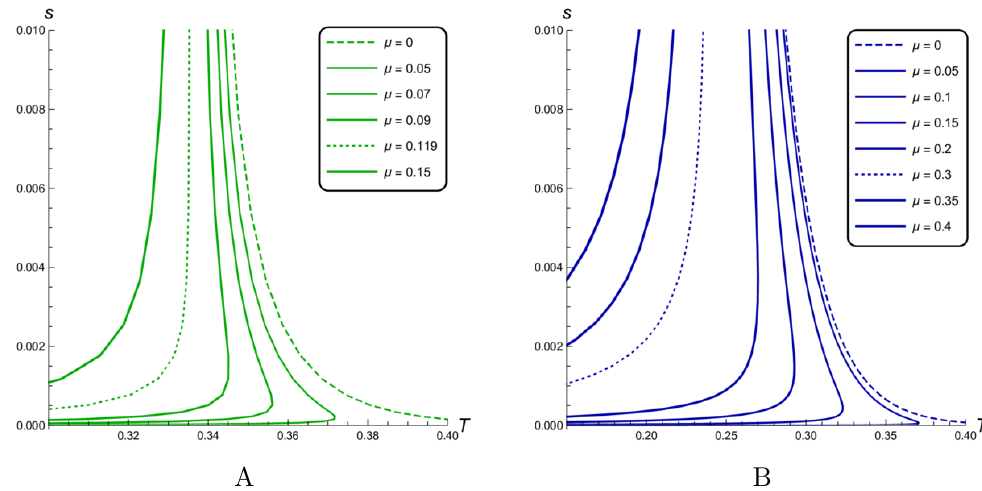
Figure 25 . Unstable second branches of s ( T ) in isotropic (A) and anisotropic case (B) cases for c = (cid:0) 1 and di(cid:11)erent (cid:22) .